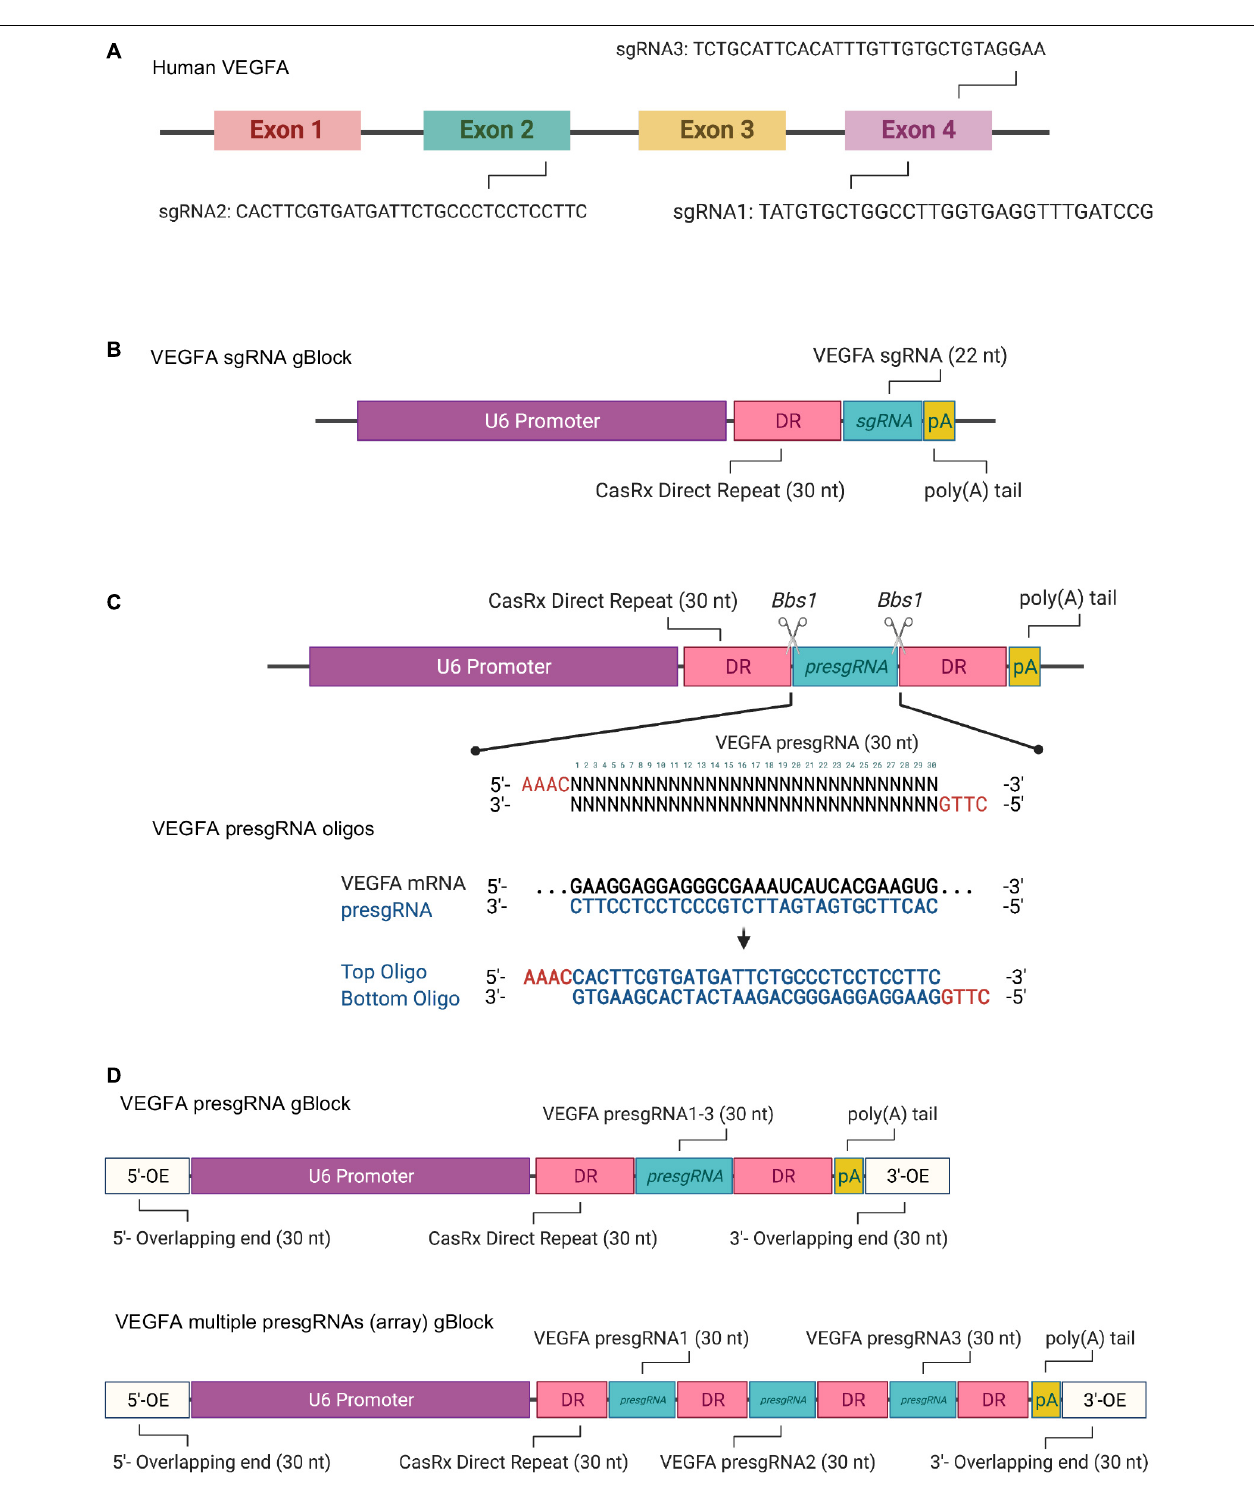
FIGURE 1 | (A) Schematic illustration of the targeting sites of the selected single guide RNAs (sgRNAs) in human VEGFA mRNA. (B) Schematic illustration of the synthetic sgRNA expression cassette for CRISPR/CasRx-mediated RNA editing. (C) Schematic illustration of the design and pre-sgRNA cloning via oligonucleotide annealing. (D) Schematic illustration of the single pre-sgRNA and multiple pre-sgRNA (array) expression cassettes for Gibson assembly. Created with BioRender.com.